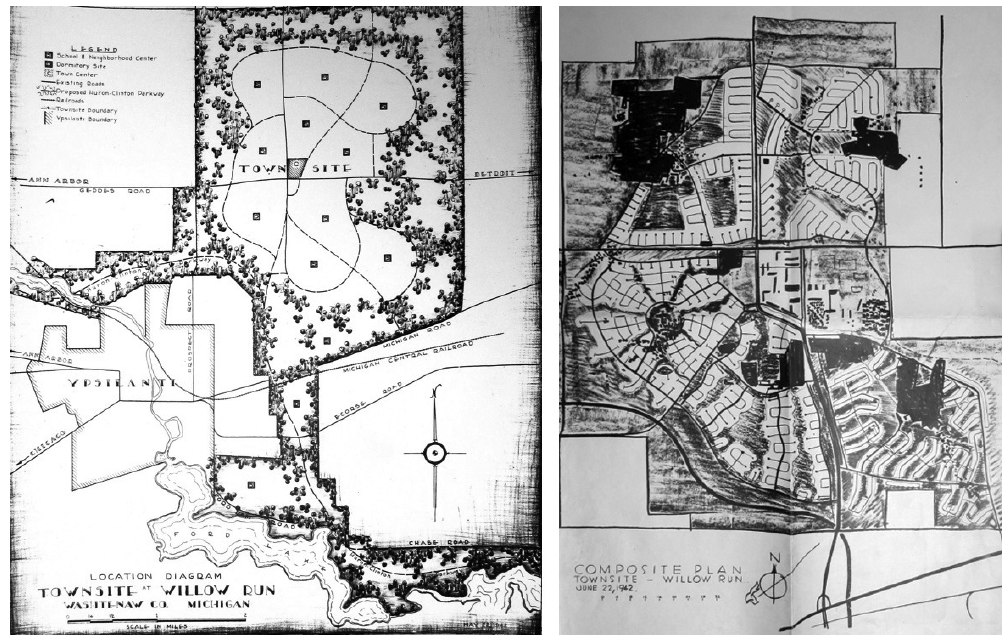
Figure 9. Willow Run, Defense City, Detroit: Location diagram (left) and composite plan (right). Sources: Stonorov (1941 [left], 1943b